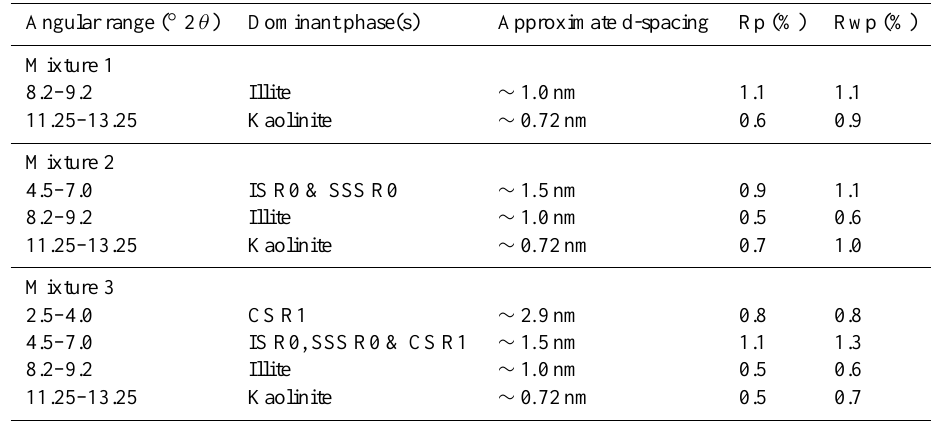
Table 3. Calculated Rp and Rwp values for selected intervals of mixtures 1, 2, and 3 calculated in PyXRD and Sybilla. (Rp and Rwp are the unweighted and weighted residual errors of the selected intervals,